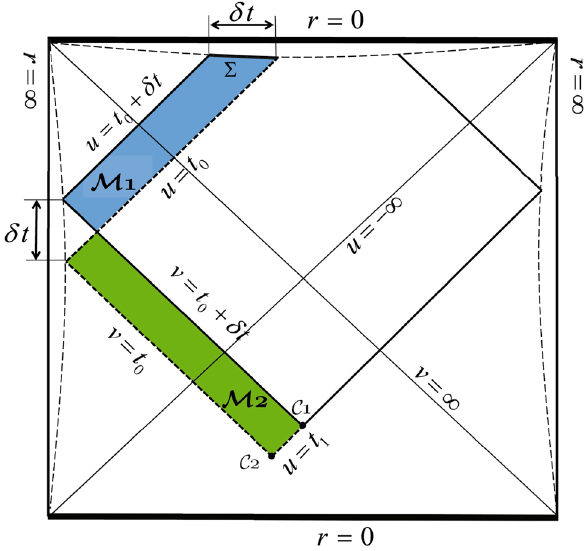
Fig. 1 Wheeler–DeWitt patches of a small mass AdS black hole in Einsteinian cubic